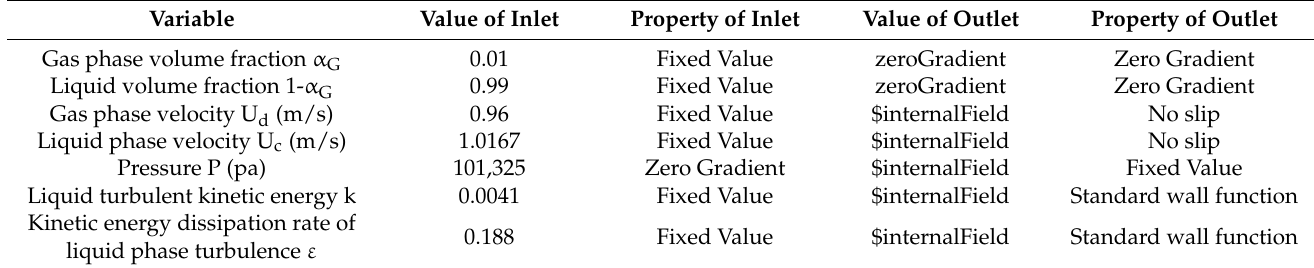
Table 4. Boundary condition parameters in